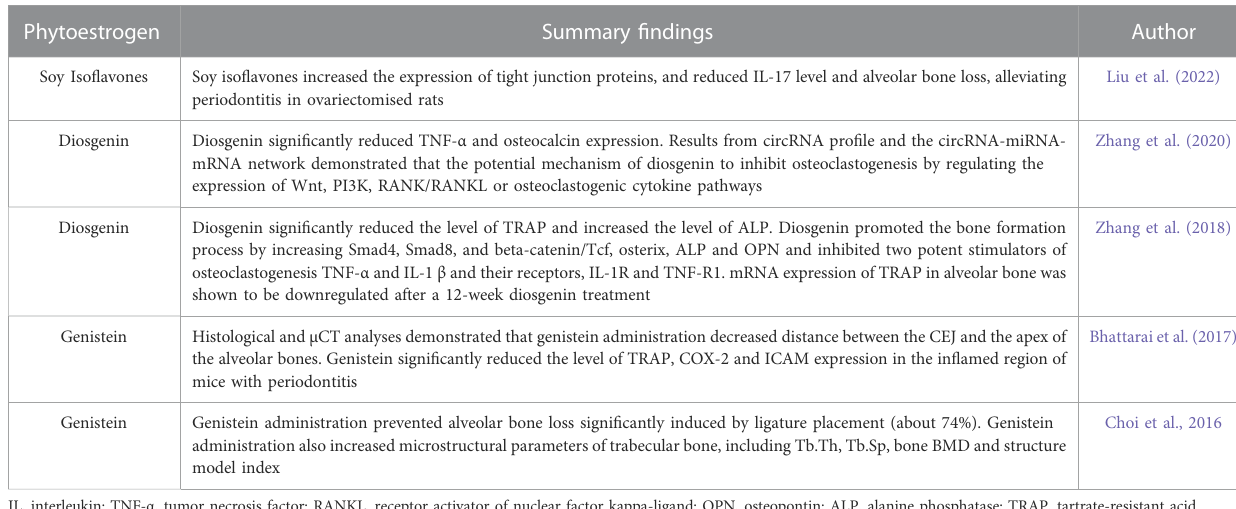
TABLE 1 Summary fi ndings on the therapeutic potential of phytoestrogens against alveolar bone